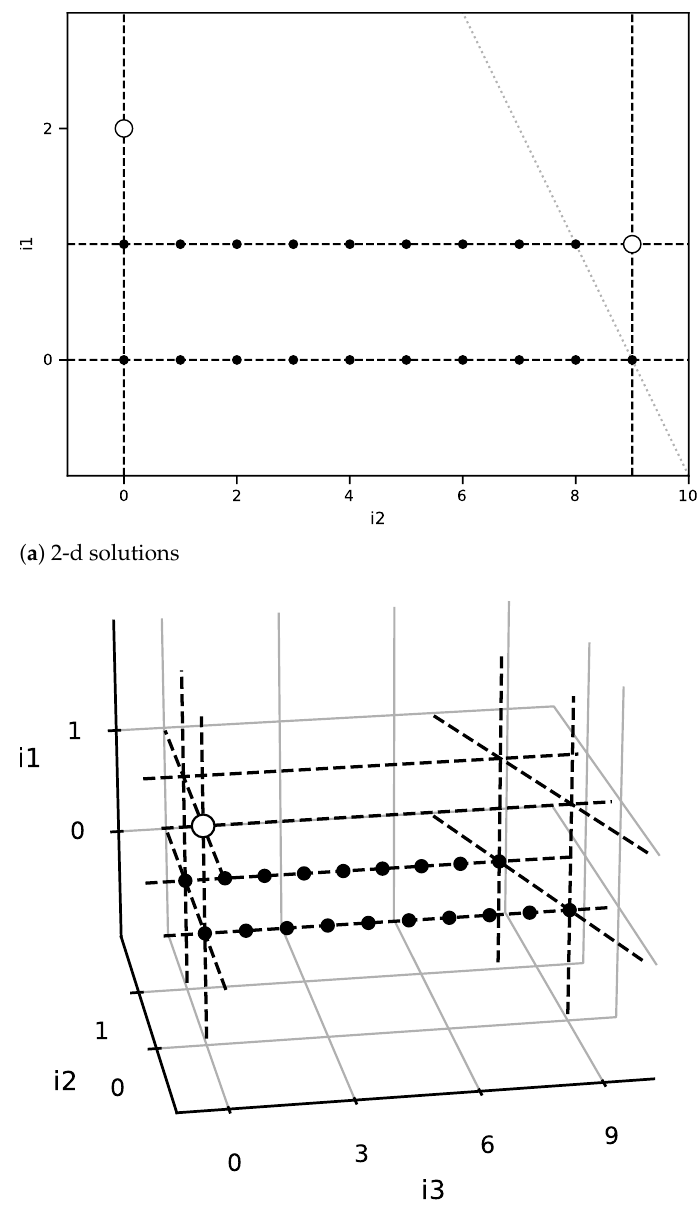
Figure 1. Geometrical view of the explored space. In this example, the analysis has reached a node representing a loop with iteration polyhedron I , which contains the full points in ( a ). Its iteration bounds, shown as dashed lines, are ( i 1 ≥ 0 ) , ( i 1 ≤ 1), ( i 2 ≥ 0 ) , and ( i 2 ≤ 9 ) . There are five different legal ways to add a point to I . The ones that correspond to points ( 1,9 ) and ( 2,0 ) are shown as hollow dots in ( a ). Both result in a different access stride in the general case, which is compared to the stride in the trace to assess its correctness. Note that the choice matching the current bounds is ( 1,9 ) . If ( 2,0 ) were selected, it would be necessary to recompute the upper bounds hyperplane for i 2 to the one depicted by the dotted line in the figure. This corresponds to the hyperplane defined by ( i 2 ≤ 9 − i 1 ) . The remaining three possible ways to add a point to I correspond to increases in the nest dimensionality. The one depicted in ( b ) is generated by adding a new outer loop to the nest (as point ( 0,1,8 ) is followed by ( 1,0,0 ) ). A new loop index i 3 will be added, and the access function f will include an associated stride computed to match the stride in the trace, as detailed in Section 3.2. Note that two additional solutions representing a dimensionality increase exist. In them, the new loop is added as the middle one (the new point is ( 1,1,0 ) ), and as the inner one (the new point is ( 1,8,1 ) ),